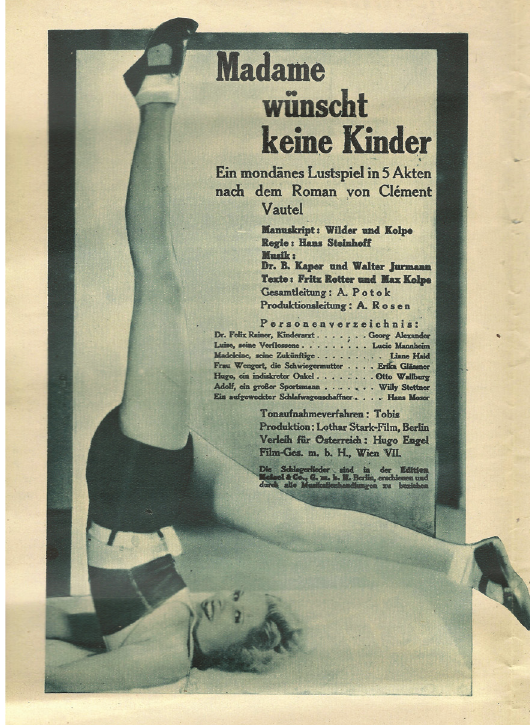
Figure 13. Page 2 of the Filmprogram accompanying the 1933 version of Madame doesn’t want children, Illustrierter Film-Kurier, Nr. 536, undated. © Christian